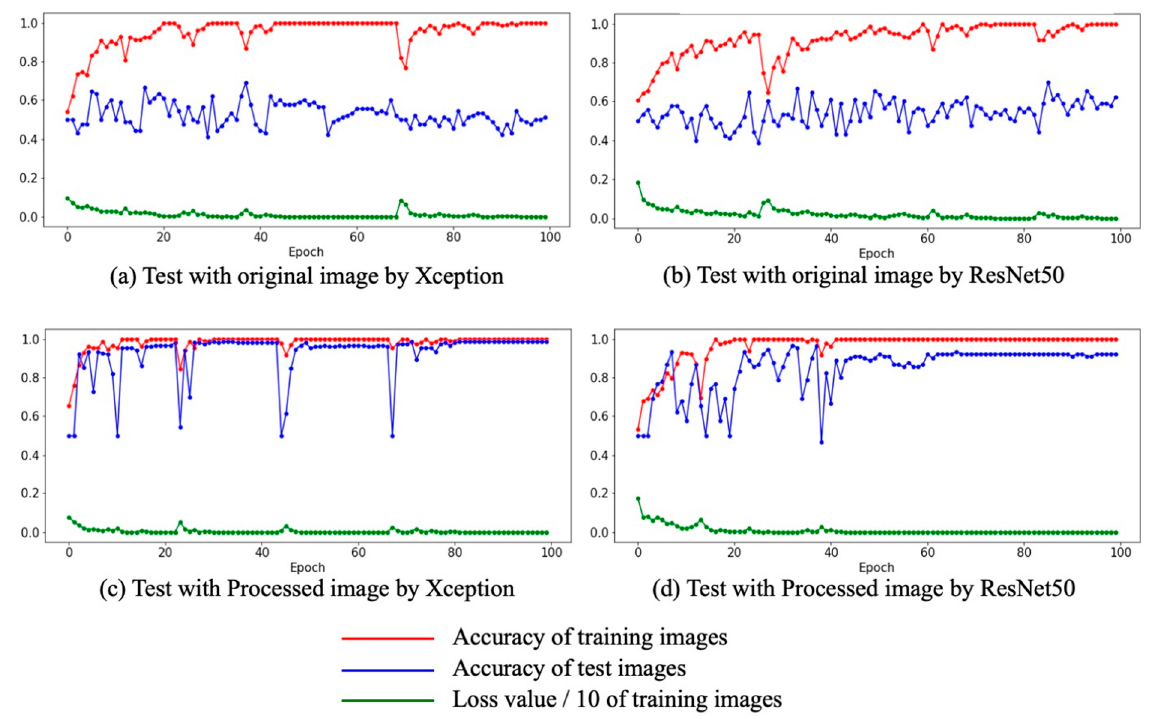
Figure 6. Results of Experiment I: ( a ) training and testing with original images using Xception; ( b ) training and testing with original images using ResNet50; ( c ) training and testing with processed images using Xception; ( d ) training and testing with processed images using ResNet50.